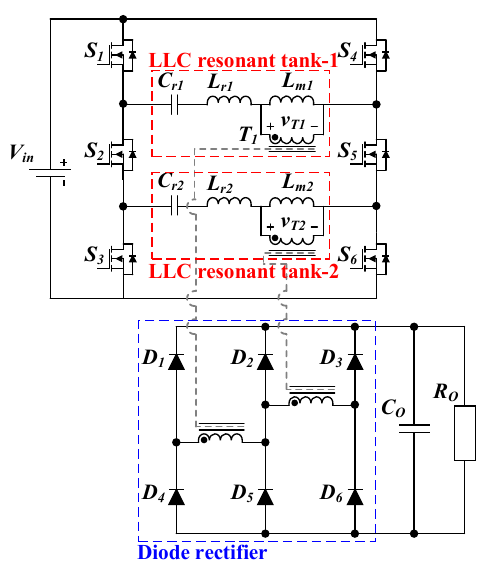
Figure 1. The dual integrated LLC resonant converter circuit.